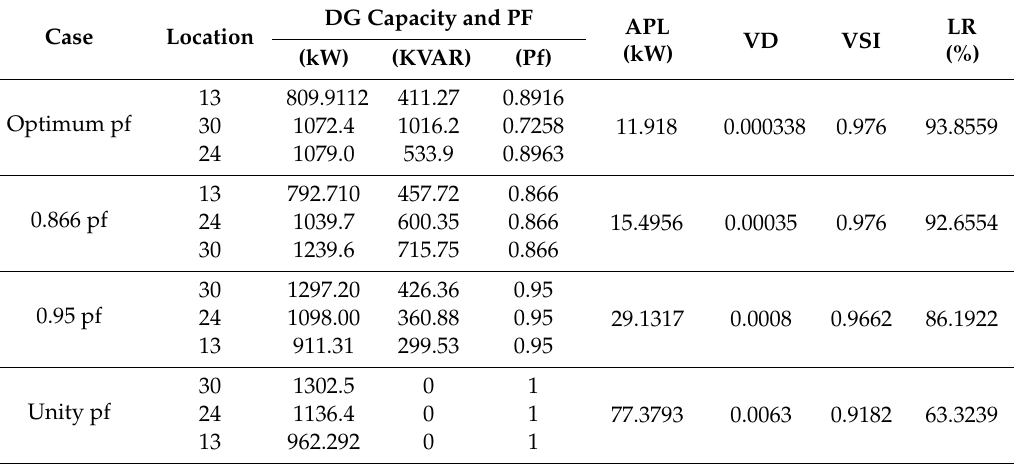
Table 5. Comparing results for di ff erent power